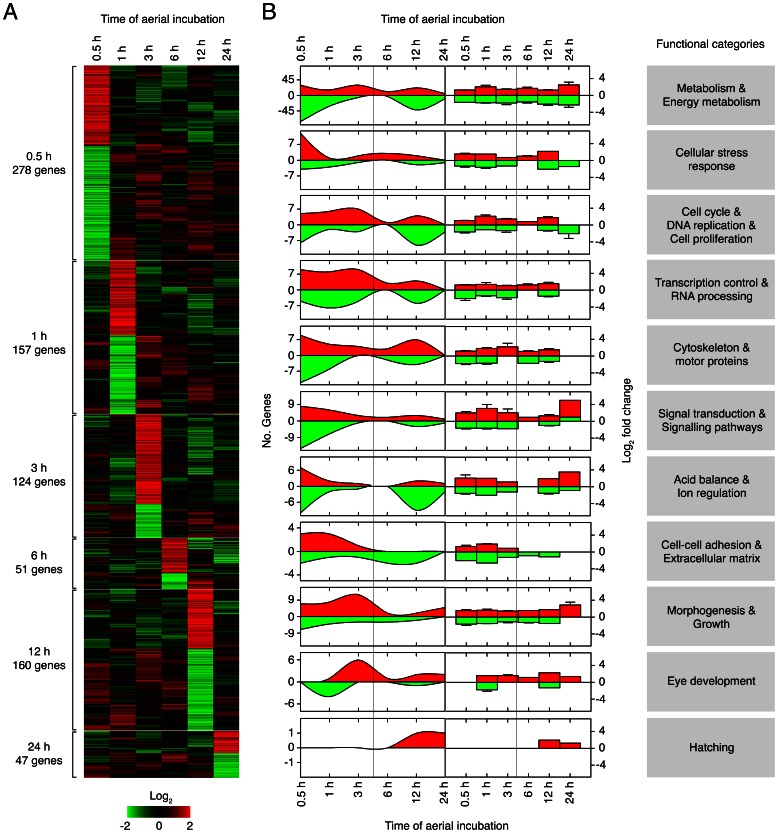
GO enrichment results of transcripts in aerially incubated Fundulus heteroclitus embryos.(A) Heatmap of annotated genes differentially expressed at different times during aerial incubation (0.5, 1, 3, 6, 12 and 24 h) ordered by time of significant (p<0.01) regulation. (B) Left panels show the number of significantly up- and down-regulated annotated genes (red and green, respectively) after 0.5, 1, 3, 6, 12 and 24 h of aerial incubation. Right panels show the log2 fold changes (mean, ± SEM when possible) at each time point of genes grouped according to functional categories as indicated on the right.